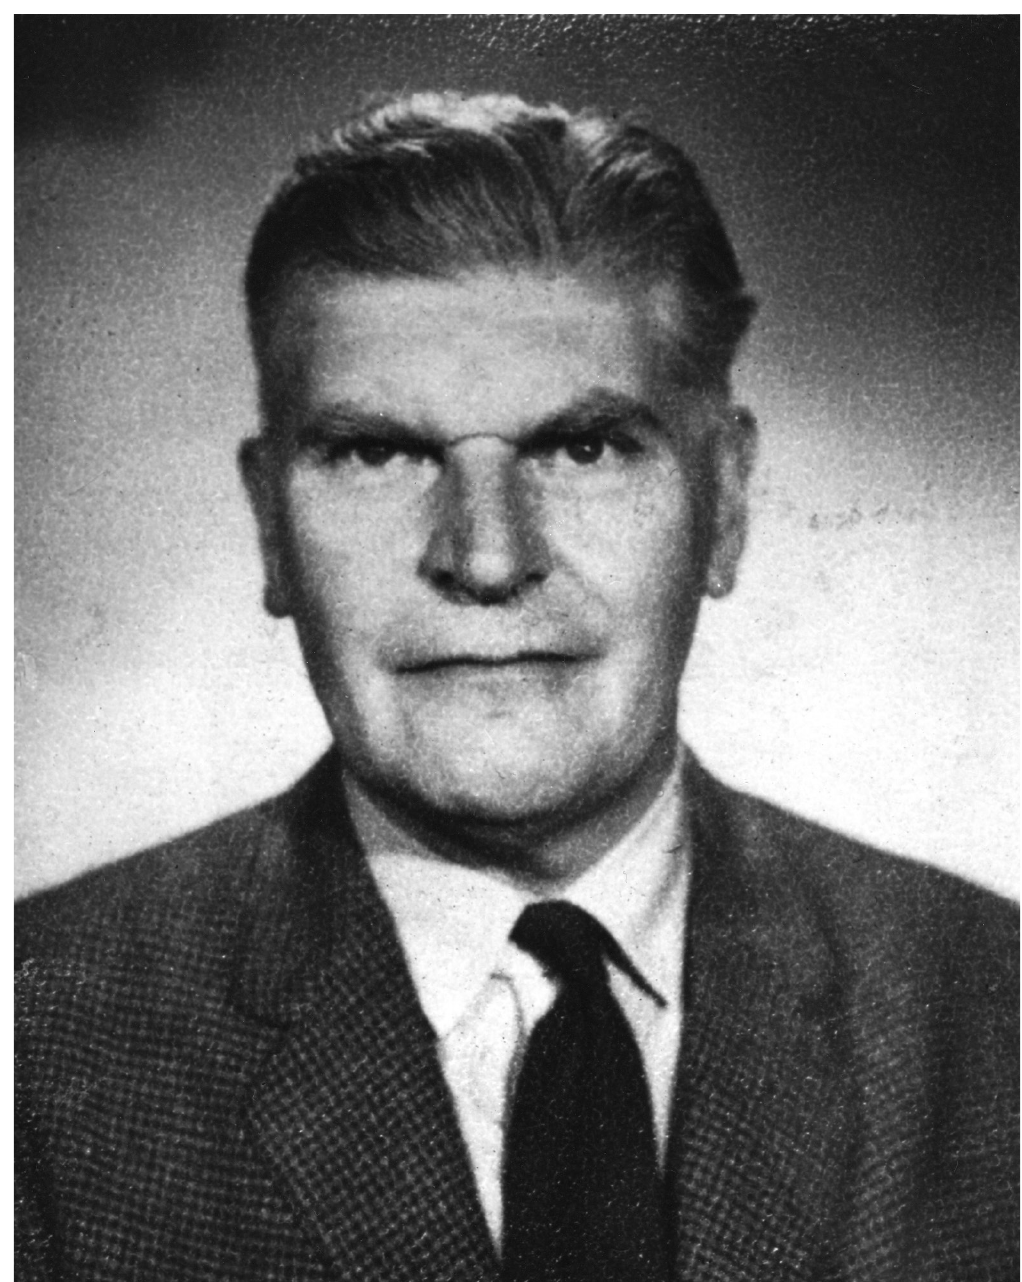
Fig. 6. Walter Douglas Hincks (1906–1961), Keeper of Entomology at the Manchester Museum (1947– 1961), photographed in the late